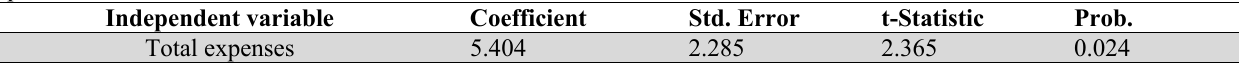
The effect of the fourth independent variable: Total expenditures of employees in Jordanian banks on the dependent variable, net profit after